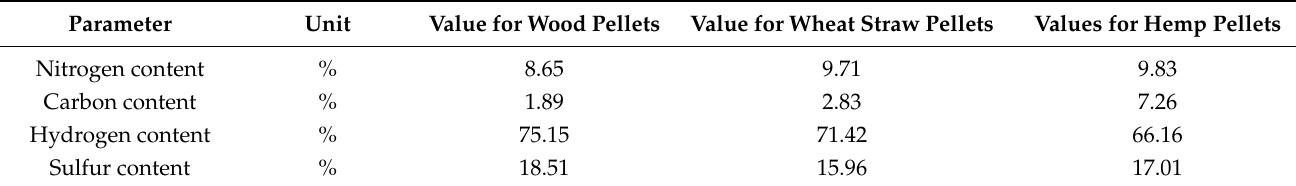
Table 7. Results of technical analysis of biomass fuels.